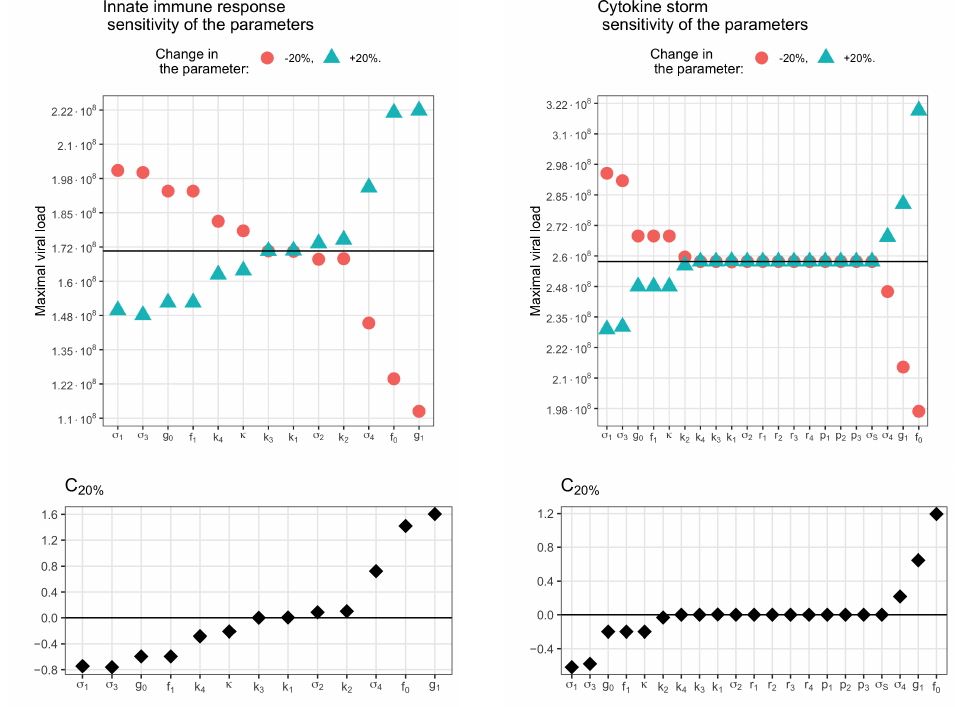
Figure 15. Sensitivity analysis of the innate immune response model ( left ) and the cytokine storm model ( right ) to the parameters. Upper row : the maximum viral load with an increase of 20% (triangles) and a decrease of 20% (dots) of each parameter compared to its value from the control set of parameters (solid line). Lower row : the corresponding sensitivity coefficients calculated by